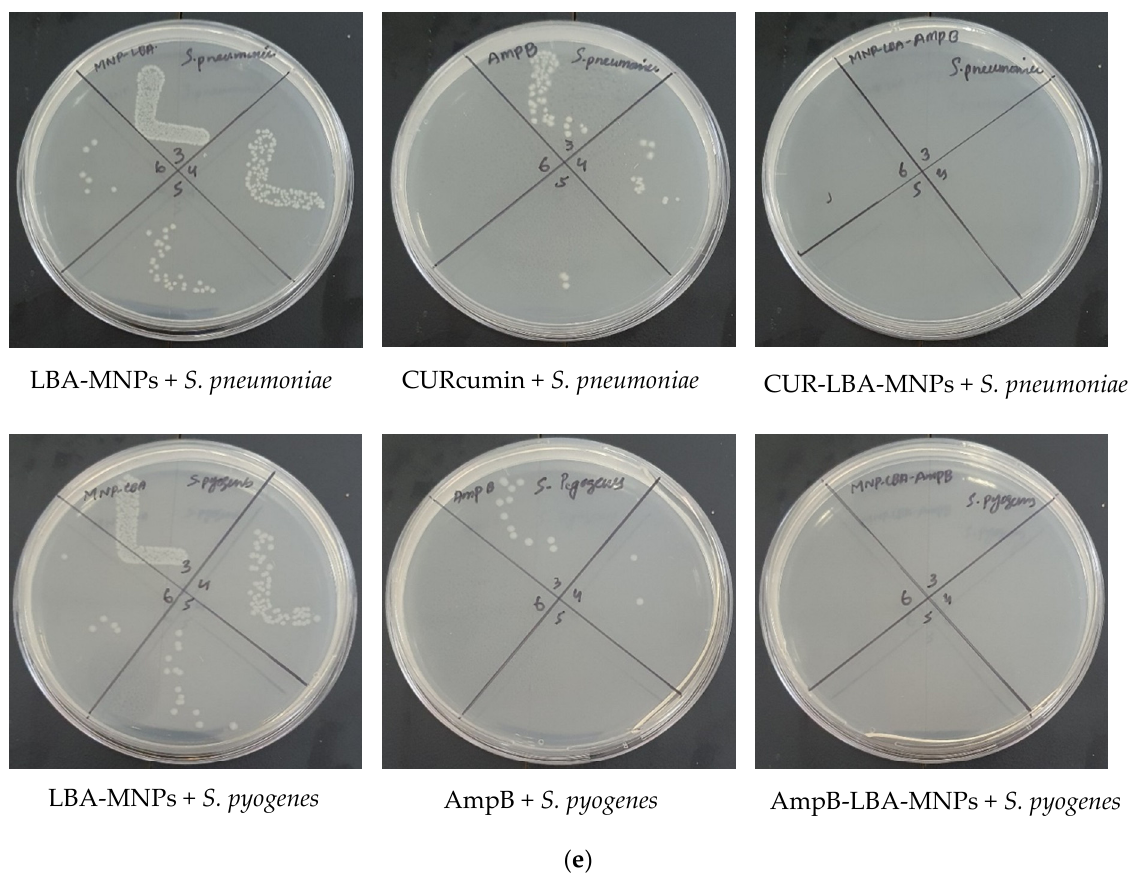
Figure 4. Drugs and drug-based magnetic NPs presented important antibacterial activity against Gram-positive pathogenic bacteria. Briefly, bacteria (1 × 10 6 ) were incubated with different drugs conjugated with MNPs and nanoparticles alone for 2 h at 37 °C. Next, the cultures were ten-fold serially diluted and plated onto the nutrient agar plates, and the plates were incubated overnight at 37 °C and counted the viable bacterial colonies on the following day. For negative control, bacteria were incubated in PBS alone, whereas for positive control, gentamicin (100 µg/mL) was used. ( a ) Antibacterial effects against S. pneumonae ; ( b ) bactericidal activity against S. pyogenes ; ( c ) against B. cereus ; ( d ) against MRSA; ( e ) illustrative antibacterial effects against S. pneumonae and S. pyogenes . The data are expressed as the mean ± standard error of several independent experiments performed in duplicate, where (*) and (**) represents when p ≤ 0.05 and p ≤ 0.01 respectively.